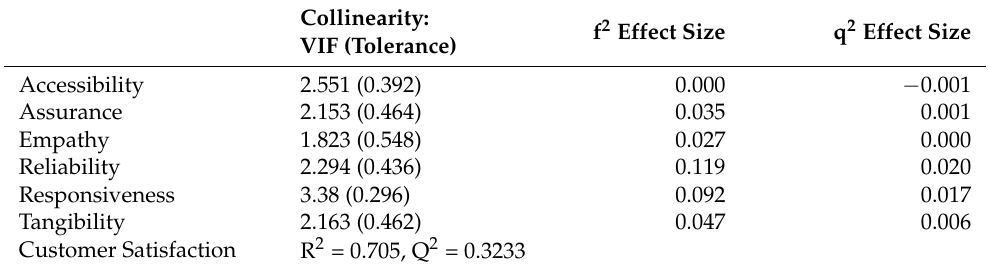
Table 5. The path coefficient, VIF, R 2 , Q 2 , f 2 and q 2 value of dimensions of service quality. Collinearity: f 2 Effect Size q 2 Effect VIF (Tolerance)